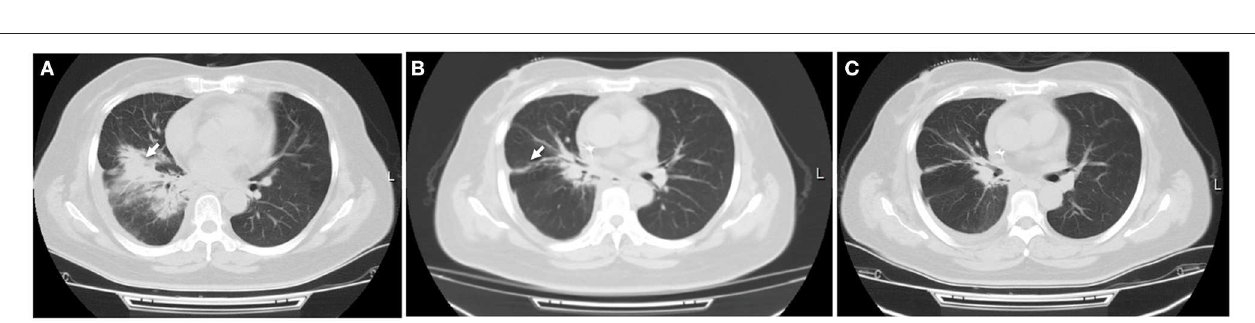
FIGURE 2 | Radiation-induced pneumonitis. (A) After receiving three-dimensional thoracic radiotherapy, a CT scan showed new patchy opacity developed in the irradiated area of hilum of the right lung, which did not occur outside the irradiated area. (B) This patient initiated steroid treatment, pneumonitis was partially resolved within 1 month, with a significantly clinical improvement. (C) Pulmonary inflammation disappeared 2 months later. White arrow indicates inflammatory